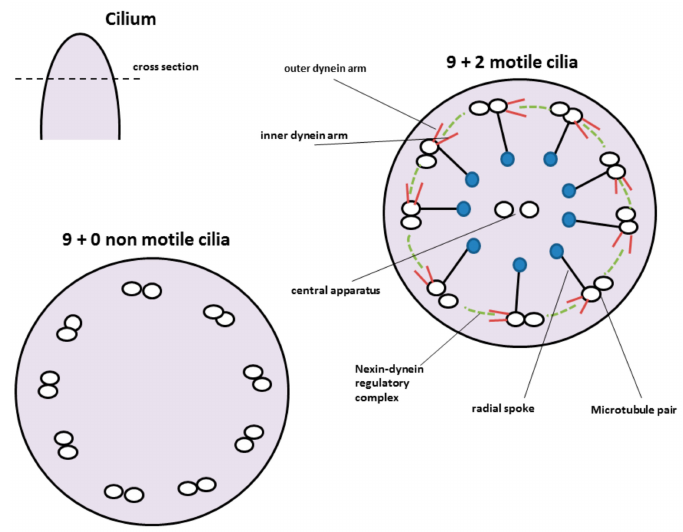
Figure 4. Structure of motile and non-motile cilia. Motile cilia show a cartwheel like structure with nine microtubule pairs surrounding a central pair. The outer microtubule pairs are connected via radial spokes to the central one. Motility of the cilium is provided by the nexin-dynein motor complex. Non-motile cilia lack the central microtubule pair as well as the nexin-dynein motor